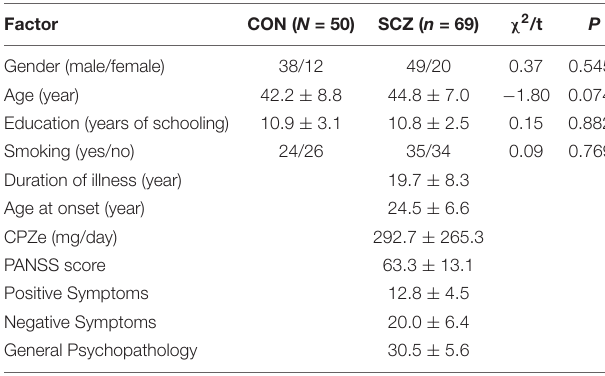
TABLE 1 | Demographic and clinical characteristics of healthy control and schizophrenia